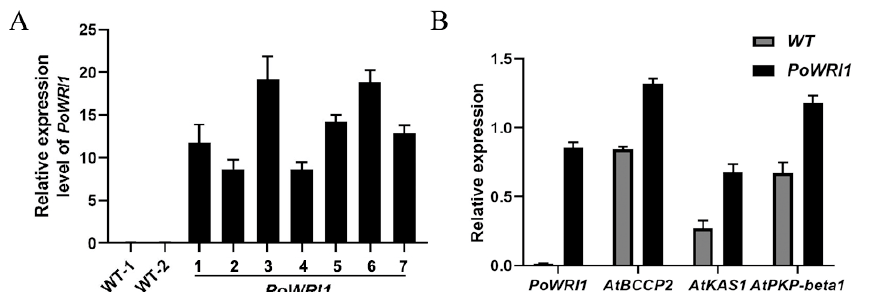
Figure 6. Expression level analysis of transgenic A. thaliana . ( A ) Relative expression level of PoWRI1 . WT-1 and WT-2 is wild-type lines, 1–7 are PoWRI1 transgenic lines. The reference gene was AtActin (AK230311.1), the primers were based on the coding sequences of PoWRI1 (MW930196). Total RNA was extracted from Arabidopsis leaves. Values are the means ± SE of three replicates carried out on cDNAs obtained from three independent mRNA extractions. ( B ) Relative expression level of WRI1 and downstream target genes in Arabidopsis leaves. The reference gene was AtActin (AK230311.1), the primers were based on the coding sequences of PoWRI1 (MW930196), AtBCCP2 (AT5G15530), AtKAS1 (AT5G46290) and AtPKP- β 1 (AT5G52920). Total RNA was extracted from Arabidopsis leaves. Values are the means ± SE of three replicates carried out on cDNAs obtained from three independent mRNA extractions.